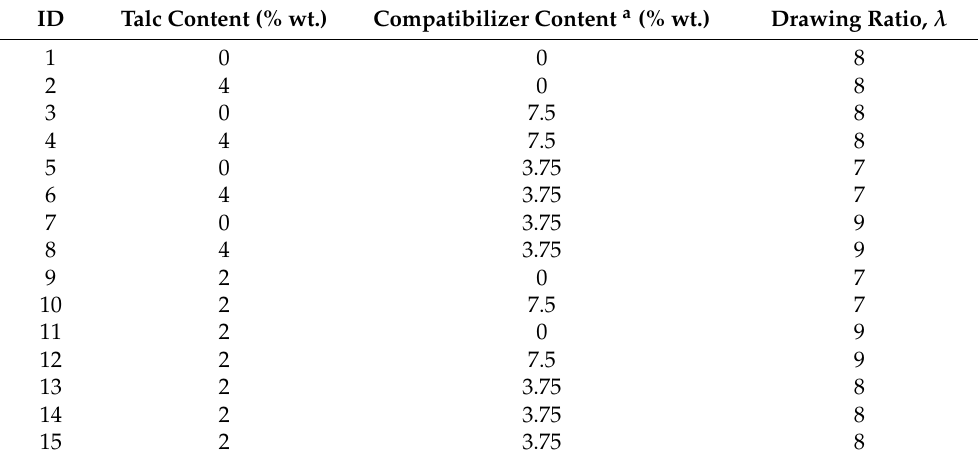
Table 2. Compositions and drawing ratios for the 15 experiments of the first DoE (composites with talc). ID Talc Content (% wt.) Compatibilizer Content a (% wt.)